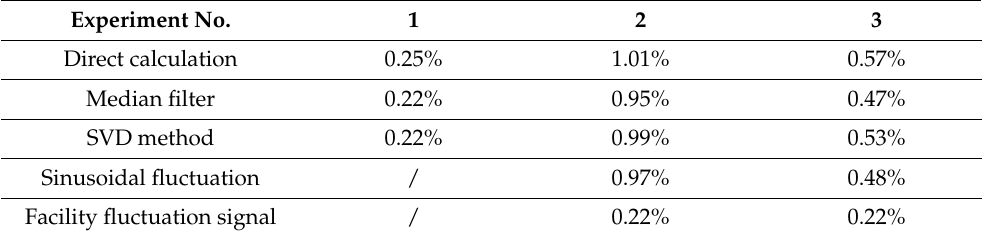
Figure 16. Experimental result for extracted signals in experiment No. 3: ( a ) the flow fluctuation signal; ( b ) frequency spectrums. Table 7. Experimental